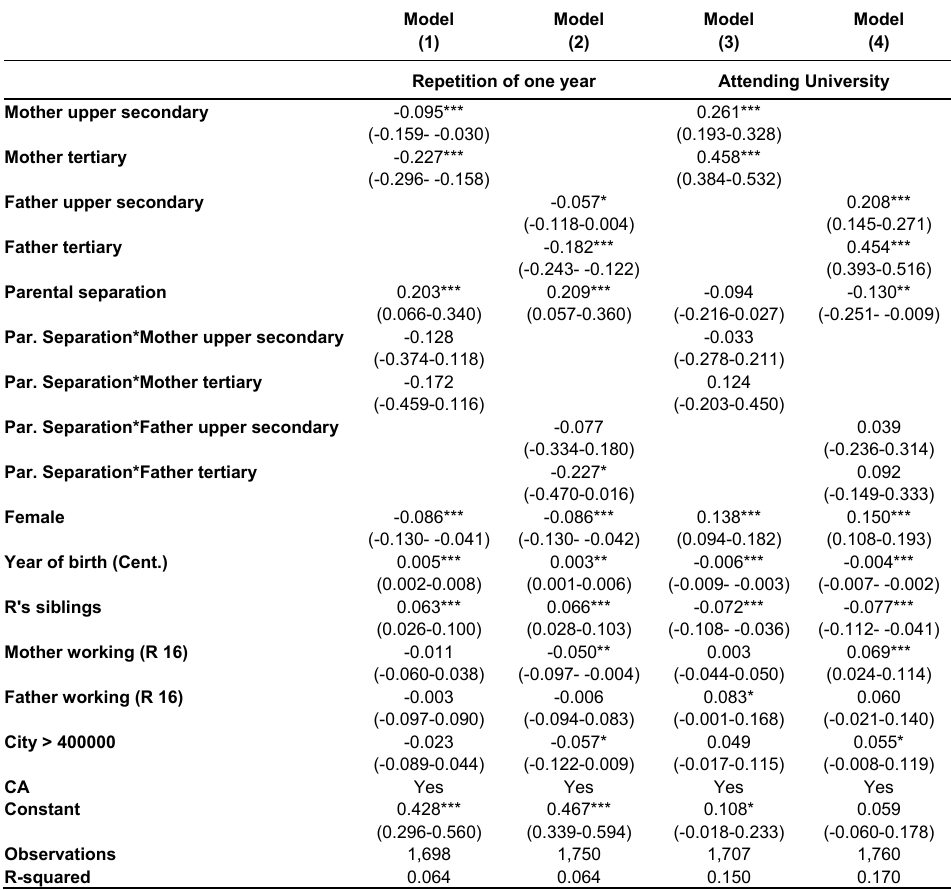
Table 4 : Linear Probability Models of repeating one year at school and attending university after parental separation by mother and father education.